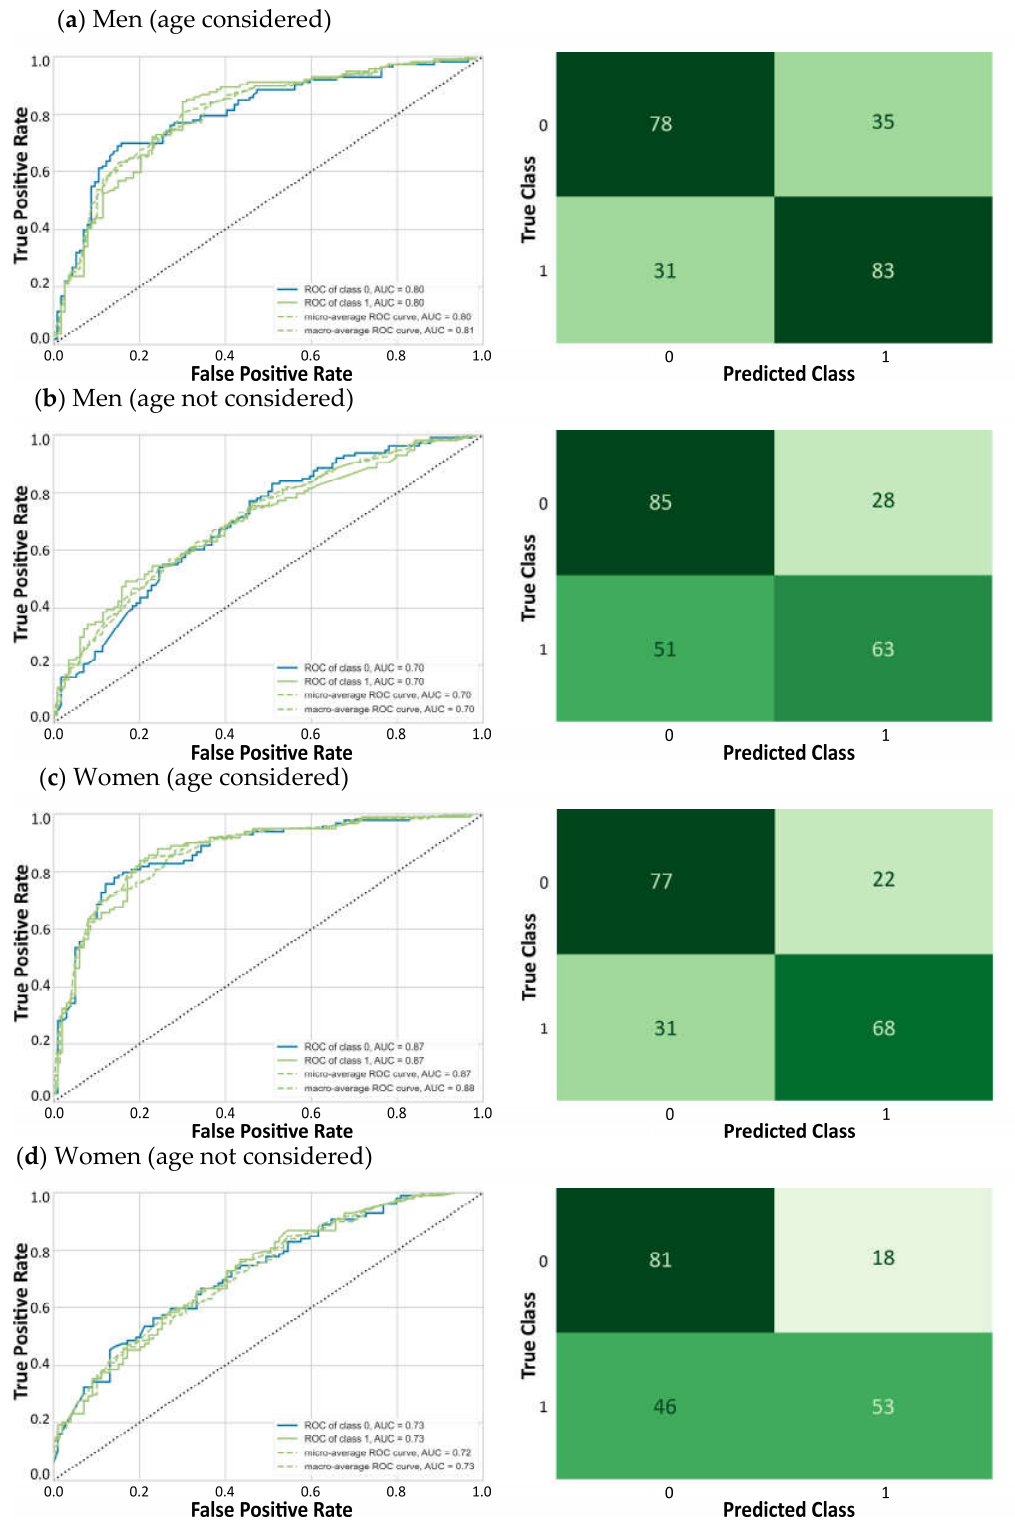
Figure 1. ROC curves and confusion matrices.